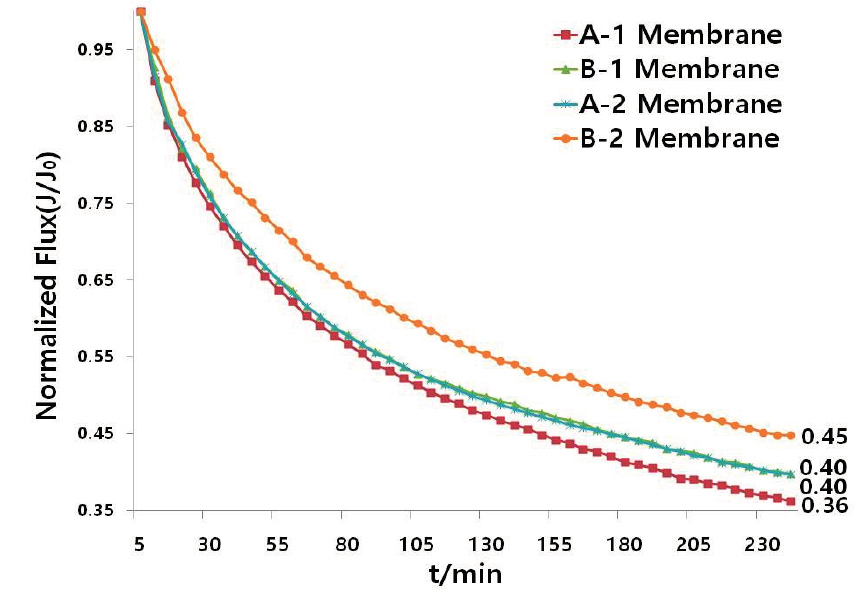
Figure 11. Normalized flux of membranes during filtration of 20 ppm HA solution at 1